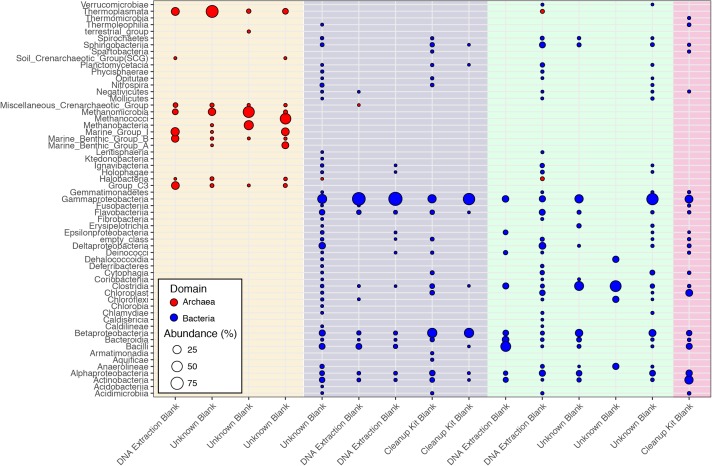
Class-level classifications of sequences associated with control samples from the CoDL. Laboratory controls were included by the primary investigators and were processed with different DNA extraction methods. The colored vertical bands represent primer sets used, from left to right: archaeal V4V5 (cream), bacterial V6 (purple), bacterial V4 (green), and bacterial V4V5 (pink). The diversity of primer sets reflects the different sequencing platforms (454 vs. Illumina) that were used by the CoDL.